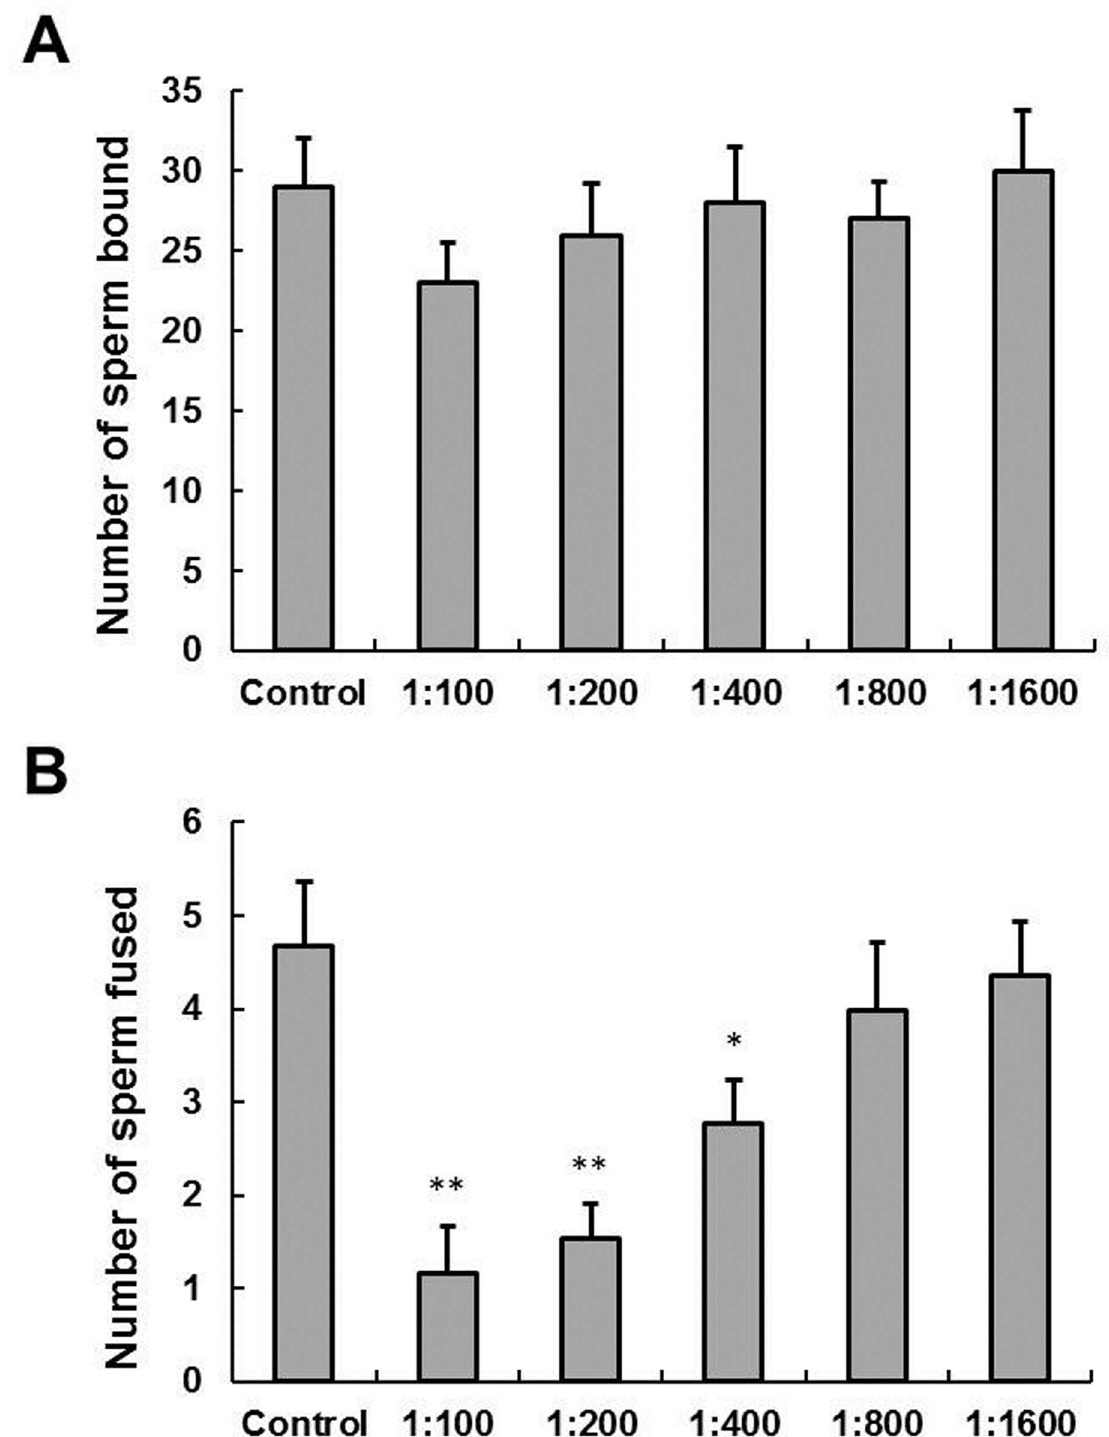
Fig 8. Effect of LYZL6 antiserum on sperm-egg binding and fusion. A) The mean number ( ± SD) of spermatozoabound per egg did not differ significantly betweenthe control and the antiserum-treated groups(control: 29 ± 3.07; anti-LYZL6serum: 1: 100, 23 ± 2.48; 1: 200, 26 ± 3.20; 1: 400, 28 ± 3.56; 1: 800, 27 ± 2.34; 1: 1600, 30 ± 3.85). B) The mean number of spermatozoa fused per egg decreasedsignificantly followingincubation of spermatozoa with higherantiserum concentrations (control: 4.68 ± 0.69; anti-LYZL6serum: 1: 100, 1.16 ± 0.51; 1: 200, 1.54 ± 0.36; 1: 400, 2.77 ± 0.46; 1: 800, 3.98 ± 0.73; 1: 1600, 4.35 ± 0.59). * P < 0.05; ** P < 0.01.